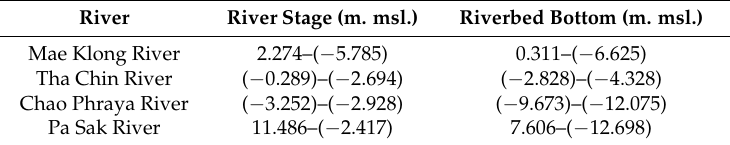
Table 3. Values of the river boundary parameter for the RIV of the initial model.